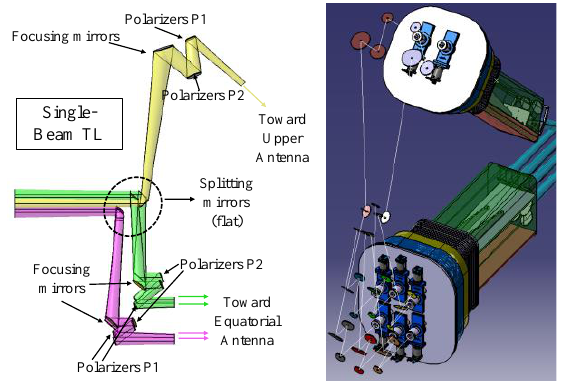
Fig. 6. Left: SBTL design in the THB. Right: upper and equatorial launchers and ex-vessel transmission